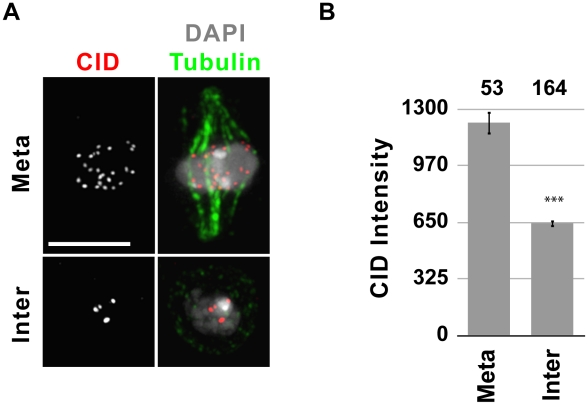
Metaphase cells contain double the amount of CID compared to interphase cells.A) Representative IF images of metaphase (meta) and an interphase (inter) cells stained with CID (red) and tubulin (green) antibodies, and DAPI (gray). Bar = 5 µm. B) Quantification of CID intensity. Total CID intensity was measured for individual cells and the mean CID intensity is shown in the graph. The number of cells quantified is shown above the graph. *** p<0.001 (paired T-test); error bars represent standard error.